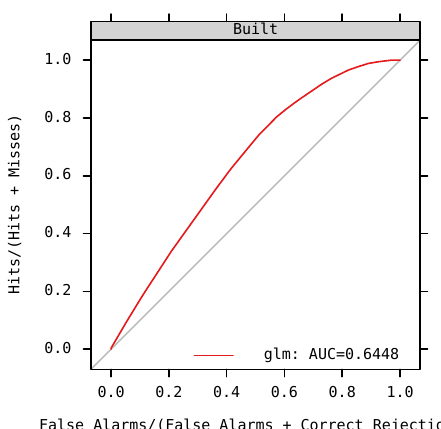
Figure 6. ROC curve showing the ability of the binary logistic re- gression model fitted on observed land use data from 1985 to predict the gain in built land between 1985 and